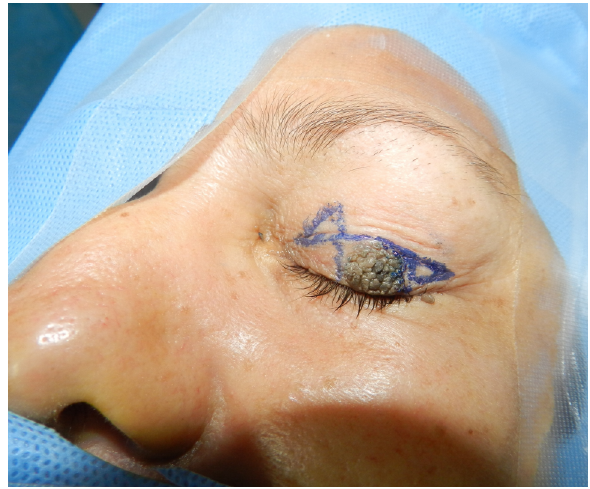
Figure 2: Advancement flap with Burow’s triangles design